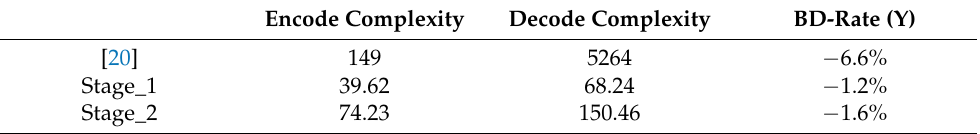
Table 6. Comprehensive comparison with [20] in terms of coding efficiency and computational complexity under the platform of CPU (HEVC anchor is